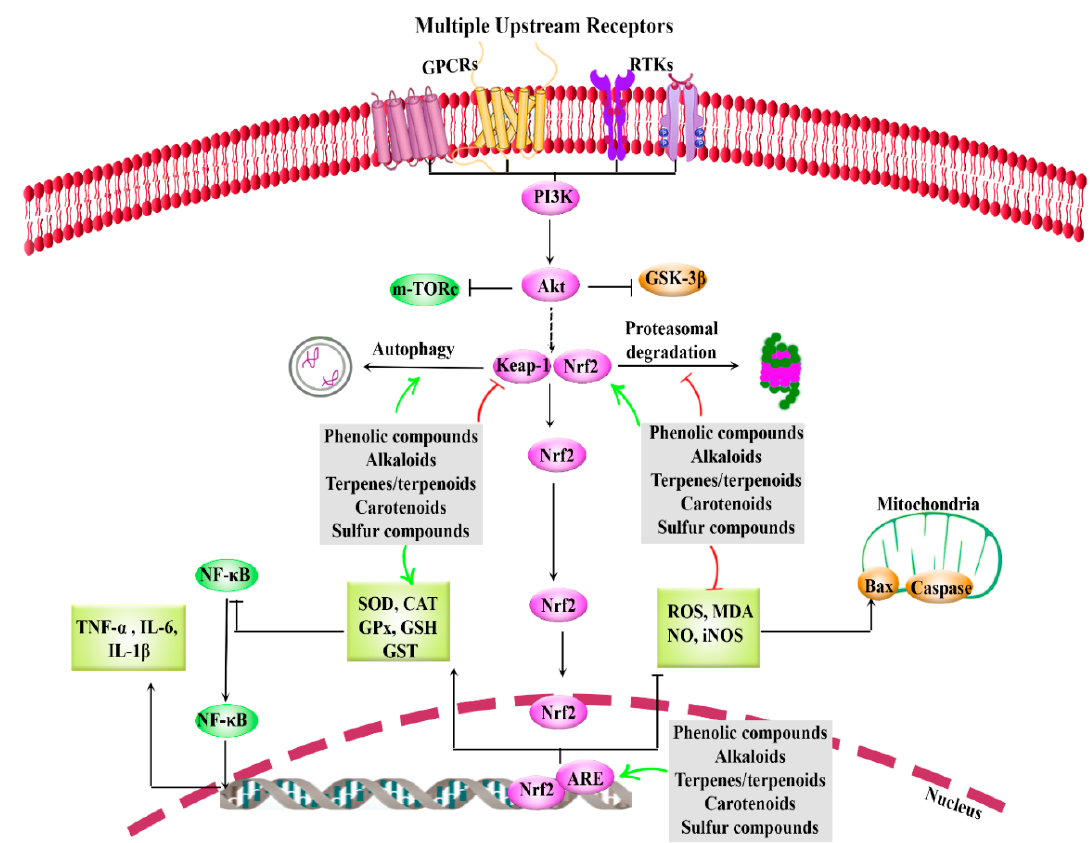
Figure 1. General overview of Nrf2/Keap1/ARE and interconnected pathways, how to be targeted by phytochemicals. Phytochemicals activate Nrf2, ARE (e.g., SOD, CAT, GPx, GSH, GST) and autophagy, while inhibits Keap1, oxidative mediators (e.g., ROS, MDA, NO, iNOS) and inflammation